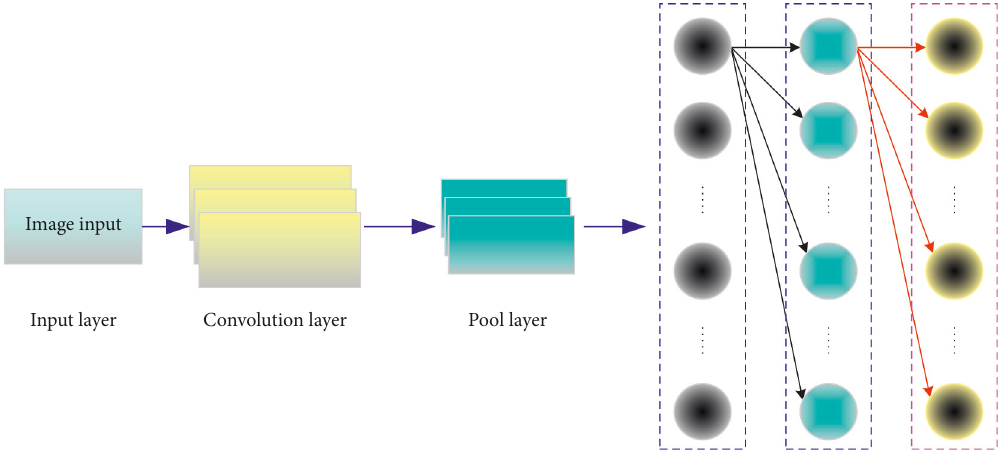
Figure 4: Structure diagram of convolution neural network.